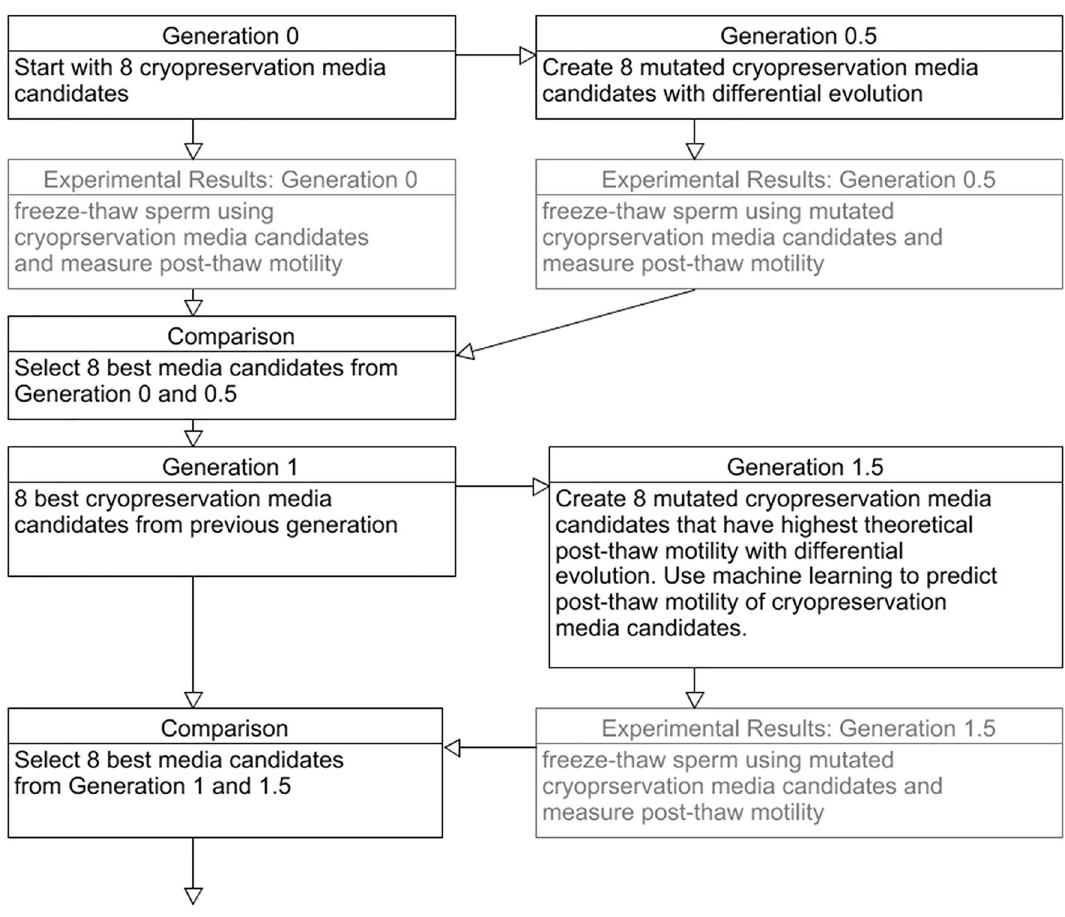
Figure 1. Flow chart of experimental